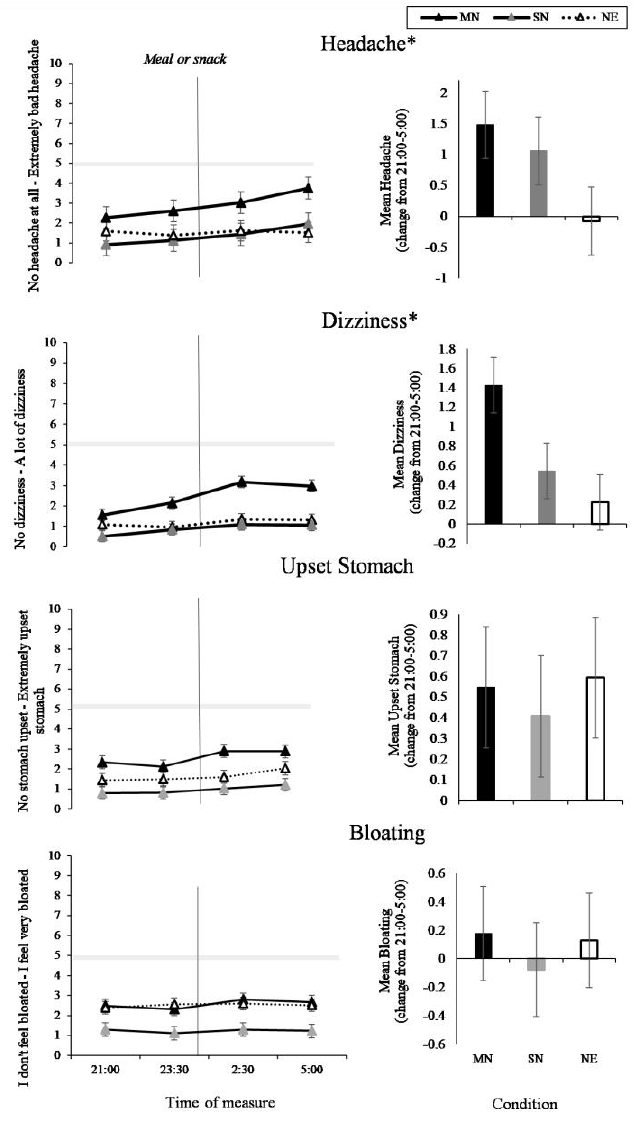
Figure 6. Headache and Gastrointestinal (GI) Symptoms VAS results from the interaction e ff ect between eating condition and time of night (line graphs), and the total mean change from 21:00 to 5:00 (bar graphs). Black lines with black markers and the black columns represent the Meal at Night condition (MN), black lines with grey markers and the grey columns represent the Snack at Night condition (SN), dashed lines with white markers and the white columns indicate the No Eating at Night condition (NE). The vertical black line on each line graph indicates when the meal or snack was consumed. The grey shaded horizontal line on each line graph indicates the midpoint of each VAS. Means presented are estimated marginal means, and error bars indicate standard errors from model estimates. (* p <